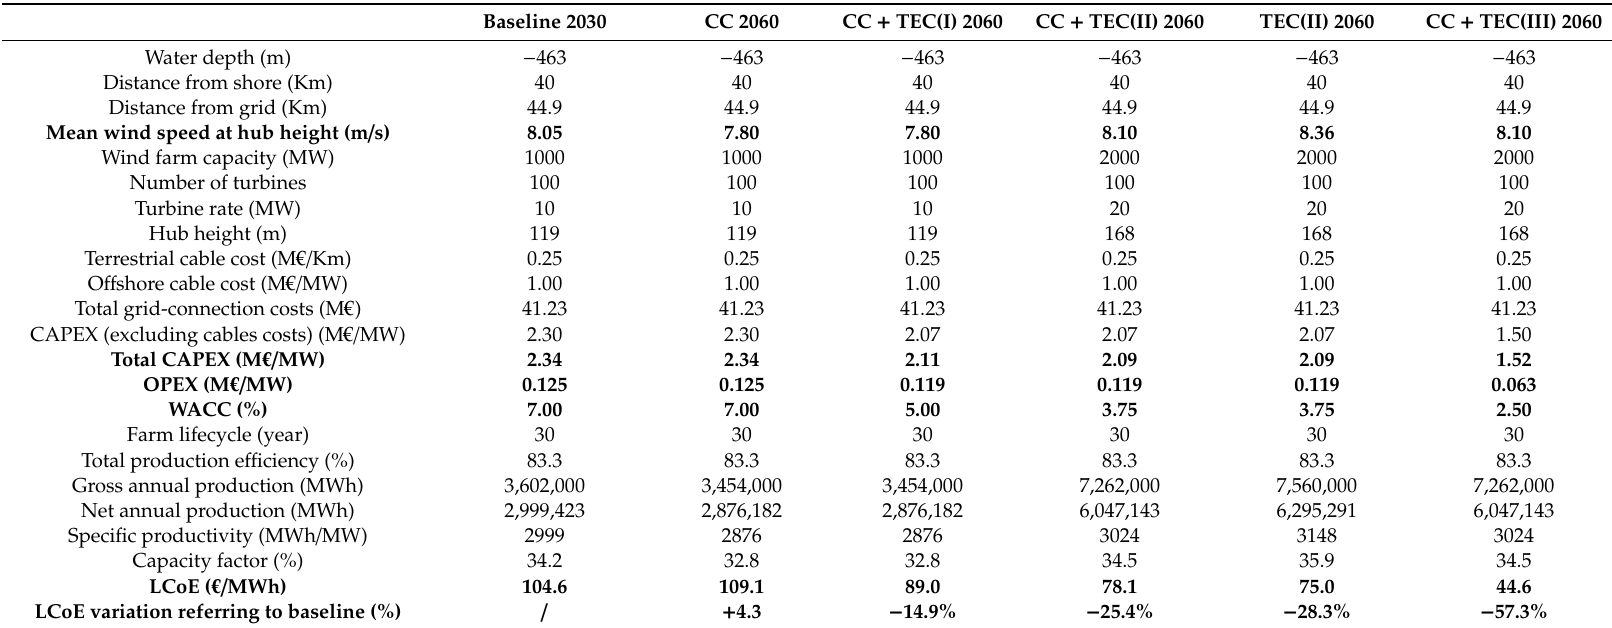
Table 6. Case study 2 (Sicily); net wind speed variation: − 0.25 m / s. (Variable parameters in